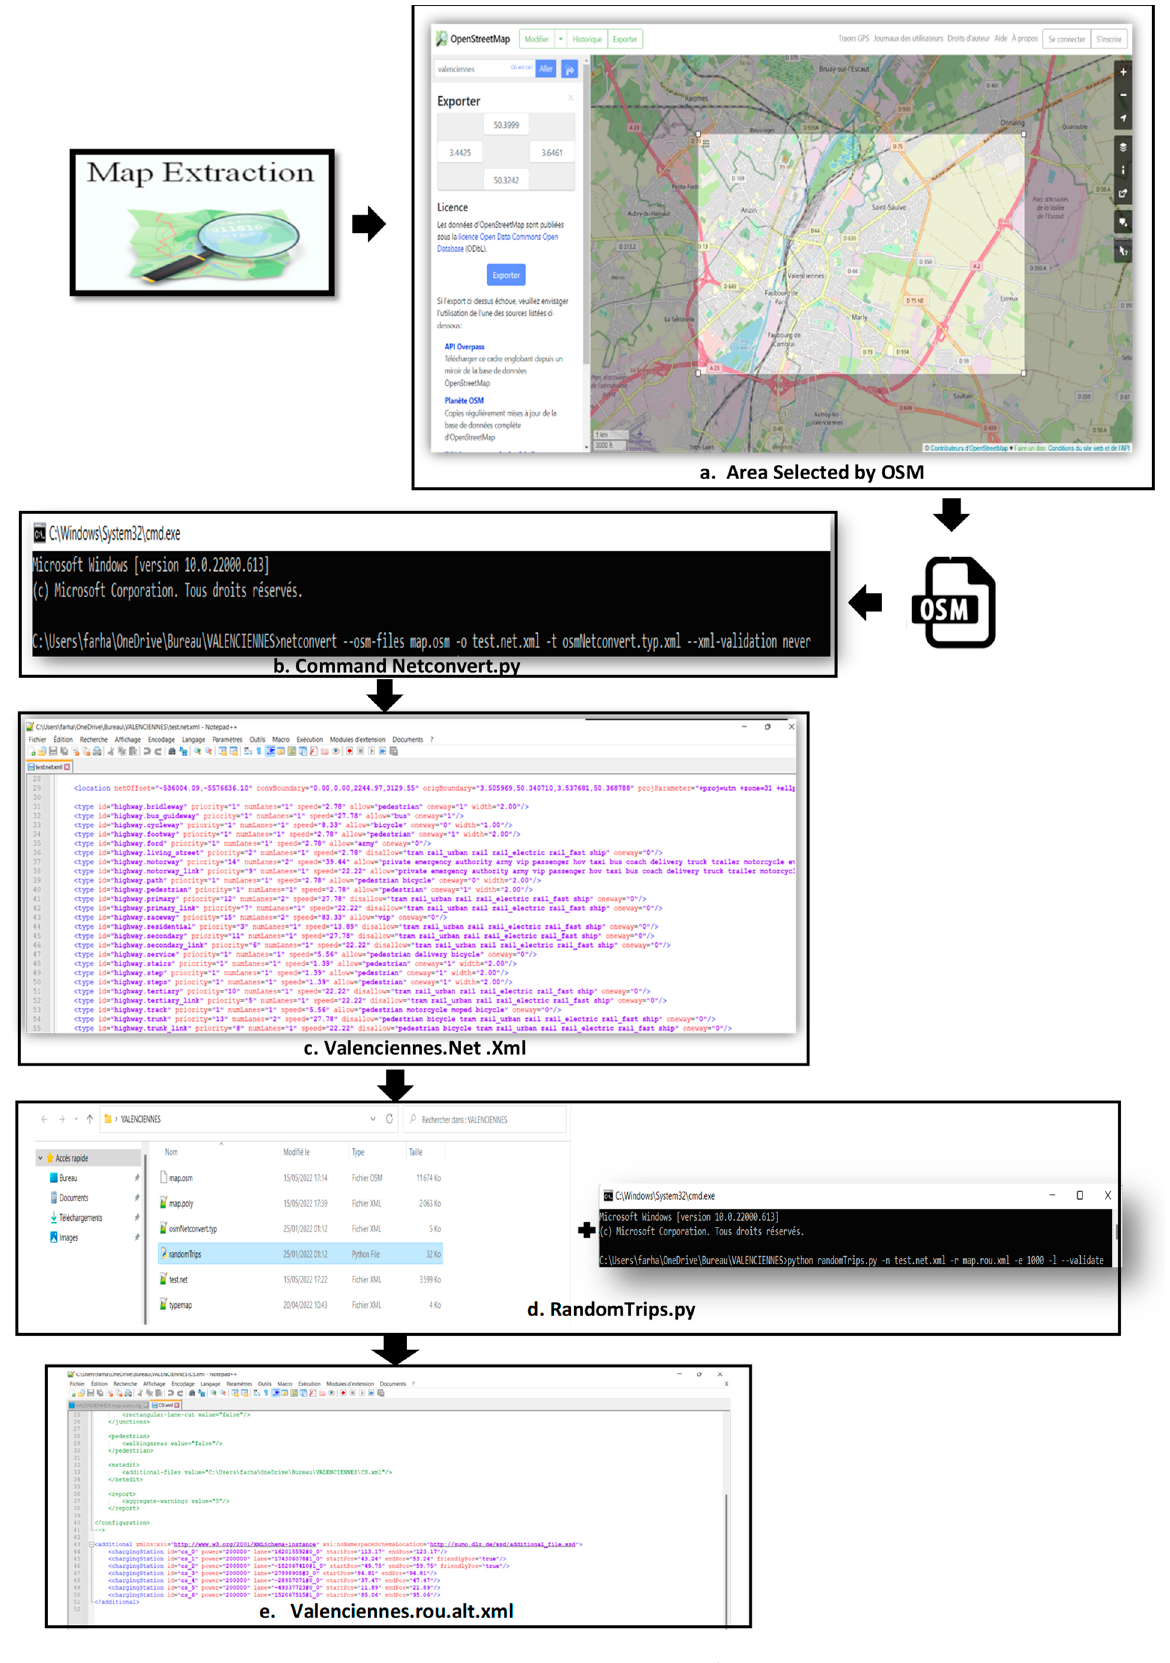
Figure 3. EV trip management using OSM and SUMO .